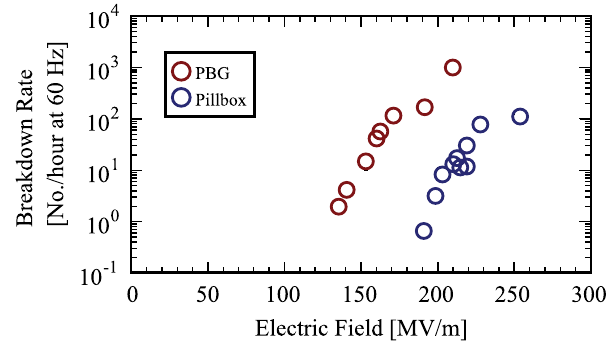
iris.FIG. 17. PBG and pillbox breakdown rate vs maximum surface electric field for 170 ns pulse length.